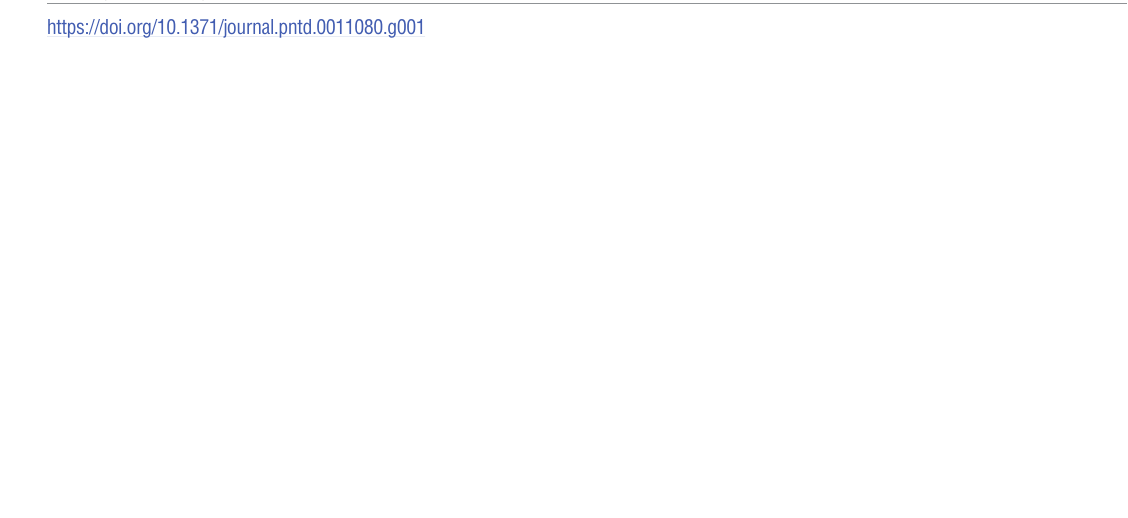
PLOS NeglectedTropical Diseases | https://doi.org/10.1371/journal.pntd.0011080 January 24,